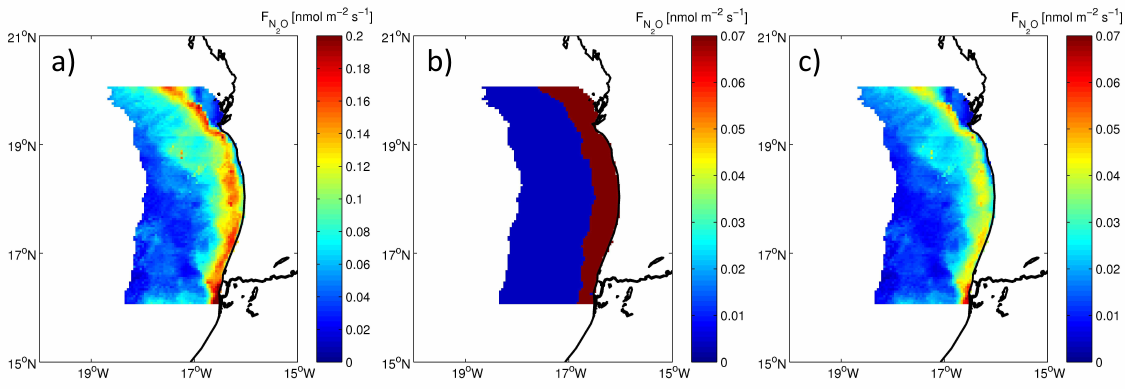
Fig. 6. (a) Regional distribution of the N 2 O fluxes calculated from SST anomalies and averaged over the sampling time using the Nightin- gale (2000) parameterization. (b) Regional distribution of the diapycnal N 2 O flux. (c) like (a) but using the Tsai and Liu (2003) parameteri- zation. Please note the different scaling of the colorbars in (a) and (b) , (c)